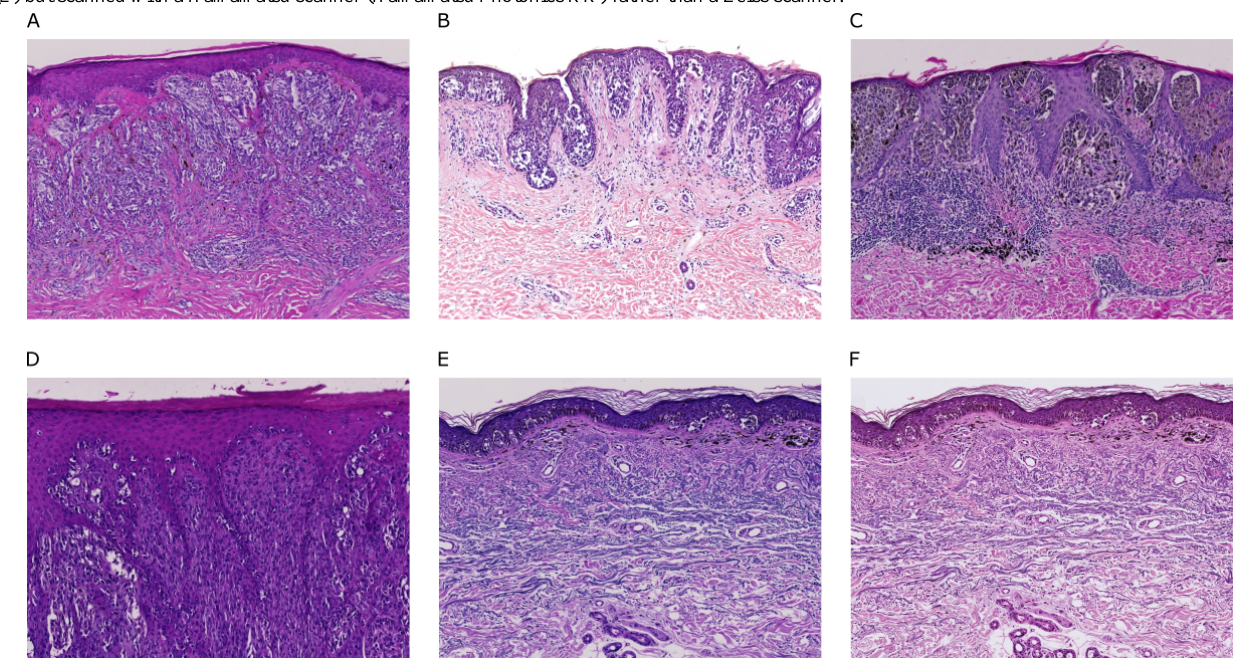
Figure 1. Comparison of exemplary whole slide image sections obtained at different institutes: (A) Institute of Pathology, University Hospital Heidelberg, University of Heidelberg, Heidelberg, Germany (Zeiss scanner; Carl Zeiss AG); (B) Department of Dermatology, University Hospital Kiel, University of Kiel, Kiel, Germany (3DHISTECH scanner; 3DHISTECH Ltd); (C) Private Institute of Dermatopathology, Mönchhofstraße 52, Heidelberg, Germany (Zeiss scanner); (D) Department of Dermatology, University Medical Center Mannheim, University of Heidelberg, Mannheim, Germany (Zeiss scanner); and (E) Private Institute of Dermatopathology, Siemensstraße 6/1, Friedrichshafen, Germany (Zeiss scanner). (F) The same slide section as shown in (E) but scanned with a Hamamatsu scanner (Hamamatsu Photonics KK) rather than a Zeiss